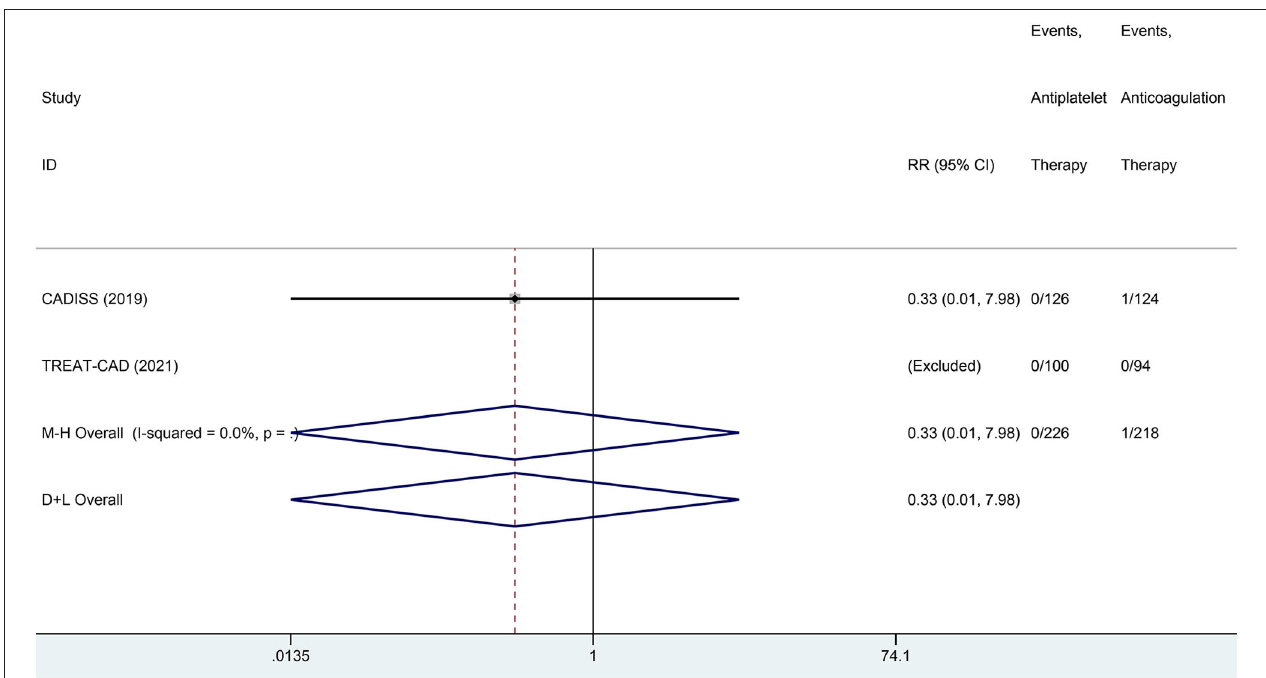
FIGURE 5 | A forest plot of comparison for intracranial hemorrhage (ICH) between the antiplatelet and anticoagulation in the ITT population.